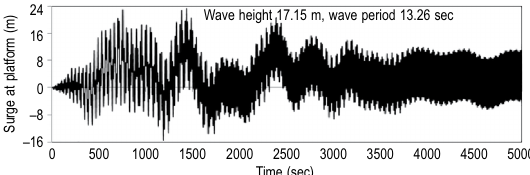
Fig. 4. Spar translational motion response in surge direction at deck level